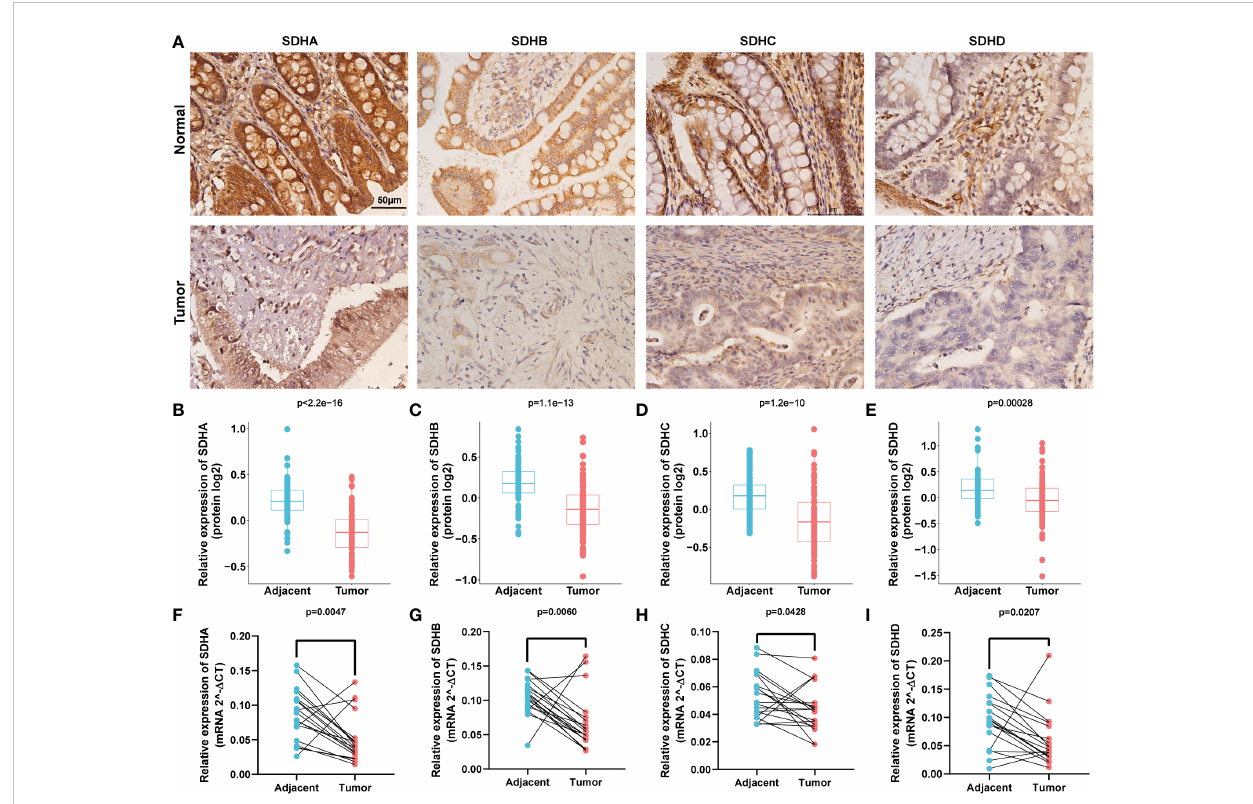
FIGURE 9 Validation of SDHs at gene and protein levels. (A) IHC of SDHs in COAD and normal tissues. (B-E) The protein expression of SDHs in COAD in Proteomic Data Commons database. (F-I) The relative mRNA expression level of SDHs in COAD and adjacent normal tissues detected by